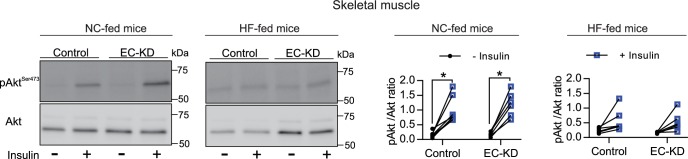
EC-Foxo1 depletion has no effect on muscle insulin sensitivity.Control and EC-FoxO1 KD mice fed NC or HF diet for 16 weeks were analyzed for muscle insulin sensitivity. Representative Western blot images (top) and quantitative analysis (bottom) of pSer473-Akt and total Akt levels in EDL muscle before and after in vivo insulin injection. Results are expressed relative to total Akt levels (NC-fed mice: Control n = 7, EC-FoxO1 KD n = 6; HF-fed mice: Control n = 6 and EC-FoxO1 KD n = 6). Data are expressed as mean ± SEM; *p < 0.05, calculated with two-tailed paired t-test.